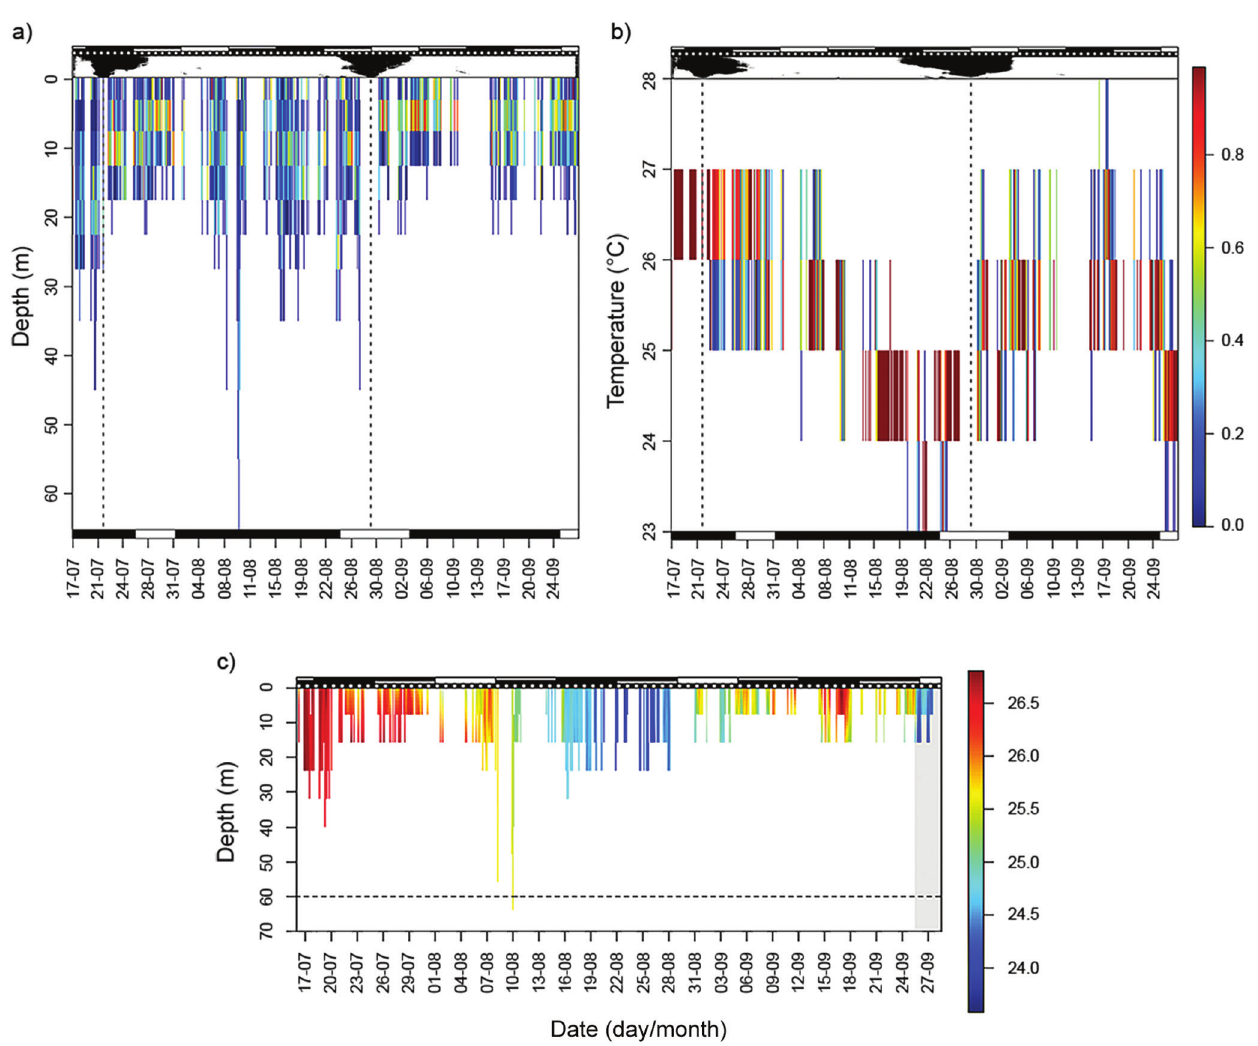
Fig. 2. Representative tracks depicting vertical usage by the Carcharhinus leucas during the track. The color scale in the upper panel inform the proportion of time spent at each depth/temperature stratum, whereas in the lower panel it represents the water temperature (°C). Above the plots, the first graduated horizontal bars with small divisions represents the diel cycle, i.e . daytime (white squares) and night time (black squares). The second graduated horizontal bar with wider divisions depicts the lunar cycle, where the all-black and allwhite rectangles depict the new and full moon phases, respectively. On the top of (a) and (b) a panel depicts the SMWGA output, and the vertical dotted lines represent statistically significant shifts in vertical behavior. Bellow (a) and (b) plots, the black and white rectangles represent transiency and residency behavior, respectively. The horizontal dashed line and shaded area in (c) represent the 60-m isobaths of the shelf break and the period when the temperatures rapidly decreased. a. depth; b. temperature; and c. temperature at